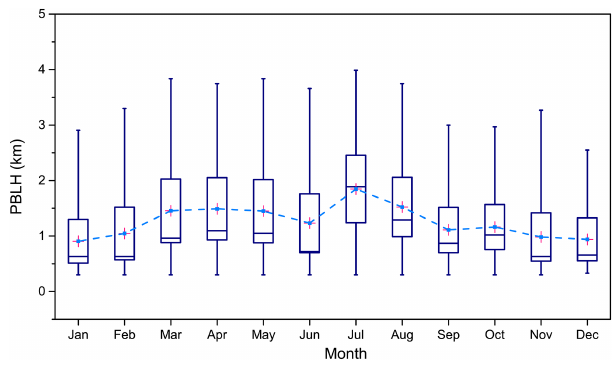
Figure 3. Monthly variation of averaged PBLH retrieved from the MPL, and their 5th and 95th percentile box plots during 2013–2015 in